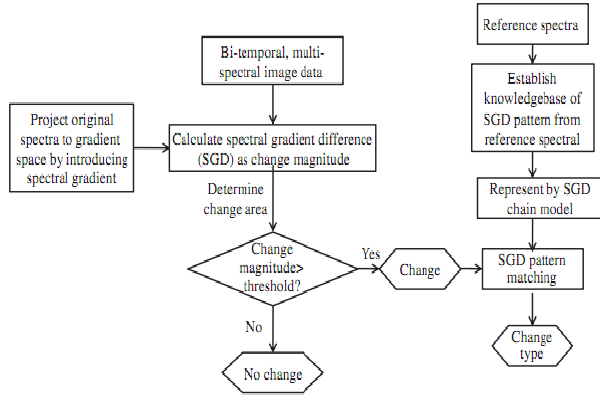
Figure 1.Framework of SGD based change detection (Chen et al., 2013)